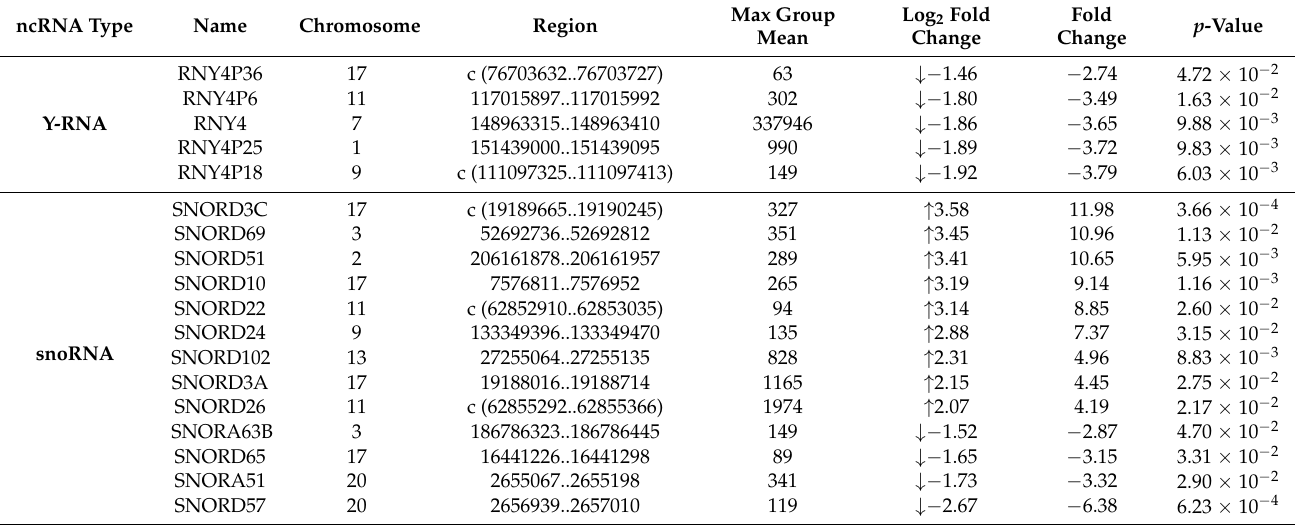
Table 6. Differentially expressed YRNAs and snoRNAs between ASD vs. Control (Absolute fold change > 2; p <